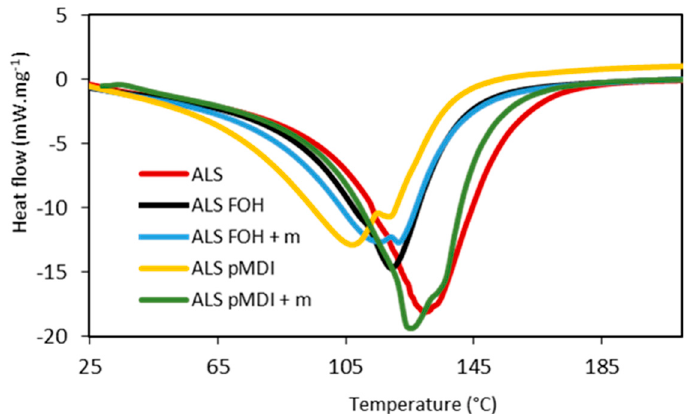
Figure 1. DSC heat of reaction thermograms of adhesive systems based on ammonium lignosulfonate (ALS), furfuryl alcohol (FOH), and polymeric 4,4’-diphenylmethane diisocyanate (pMDI) as crosslinkers, and with or without mimosa tannin (m).